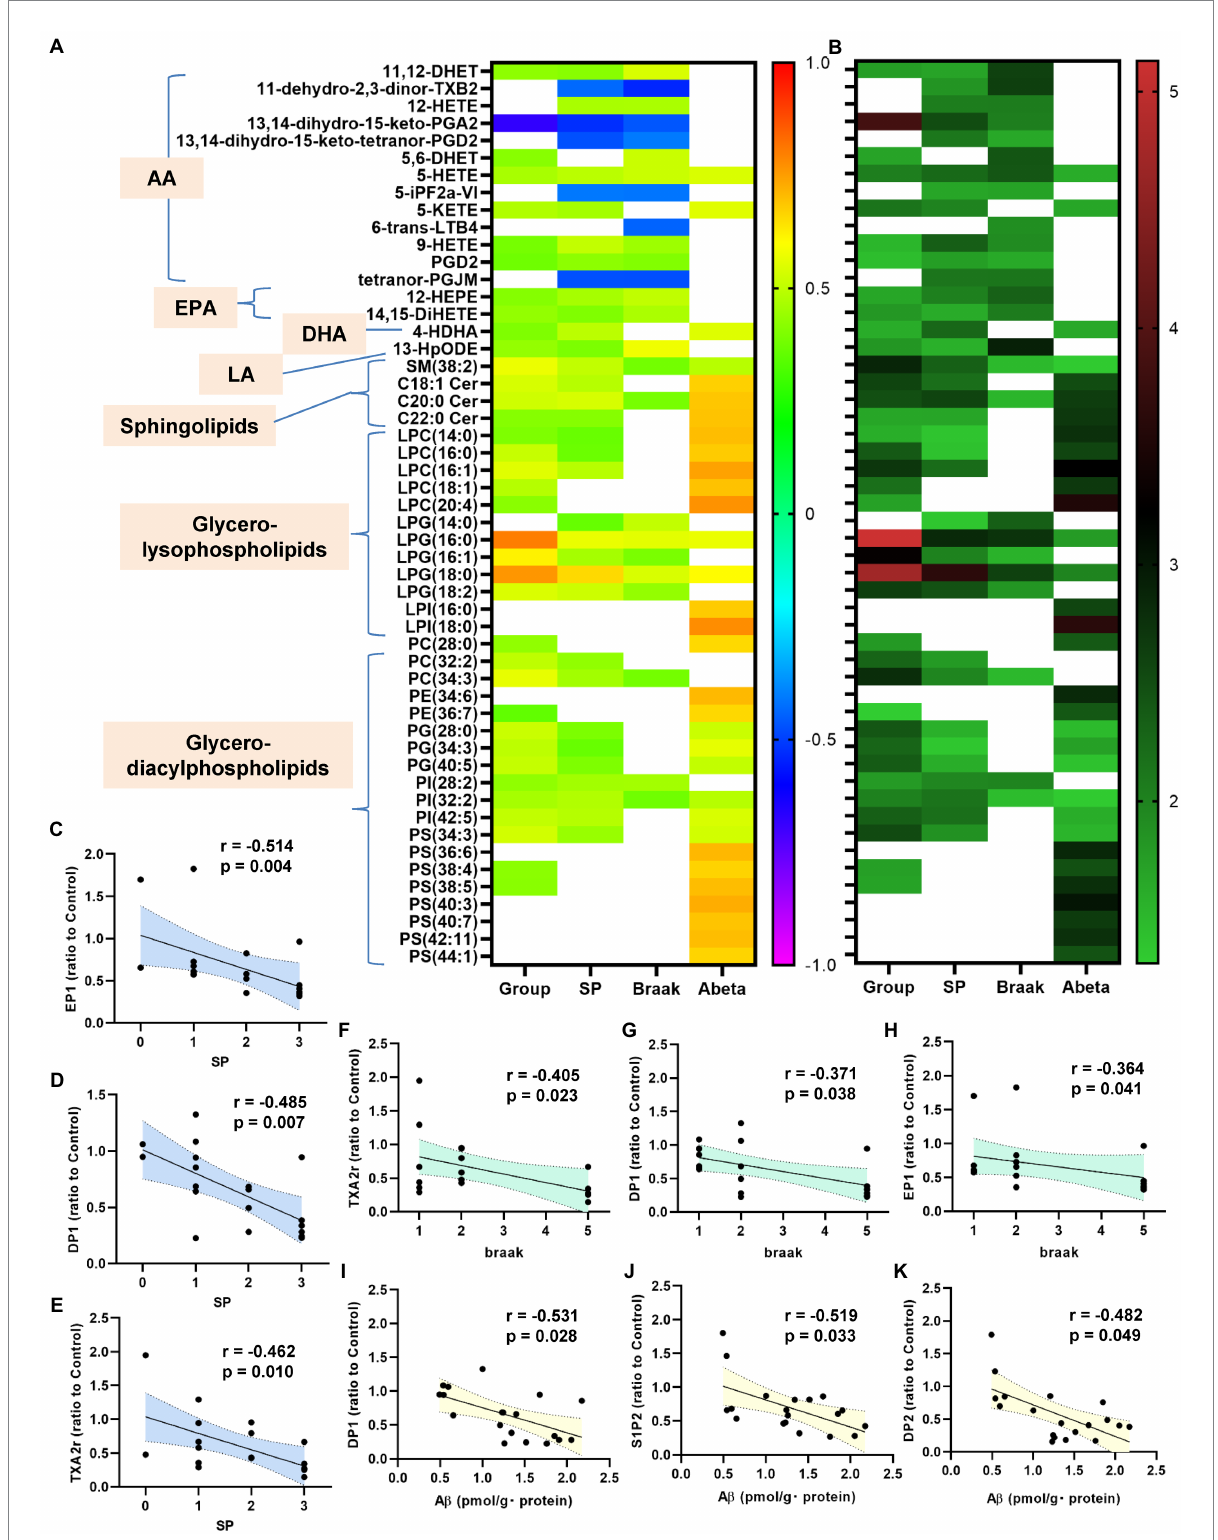
FIGURE 5 Correlations between bioactive lipids/their receptors and the clinical phenotypes. The correlations between the bioactive lipid/their receptor expression levels and the clinical phenotypes (group [control, Cerad-b, and AD], SP, Braak stage, and Ab) were examined using the Kendall rank correlation for correlations with the diagnostic group, SP, and Braak stage, and the Spearman rank correlation for Ab, using age and sex as the covariates of interest. (A,B) The correlation coefficients and the p -values of the top 20 lipid mediators with the lowest p values in the analysis of the correlations with any specific clinical parameters (group [control, Cerad-b, and AD], SP, Braak stage, and Ab) as heat maps. (C–K) The significant correlations between the lipid receptor expressions and clinical